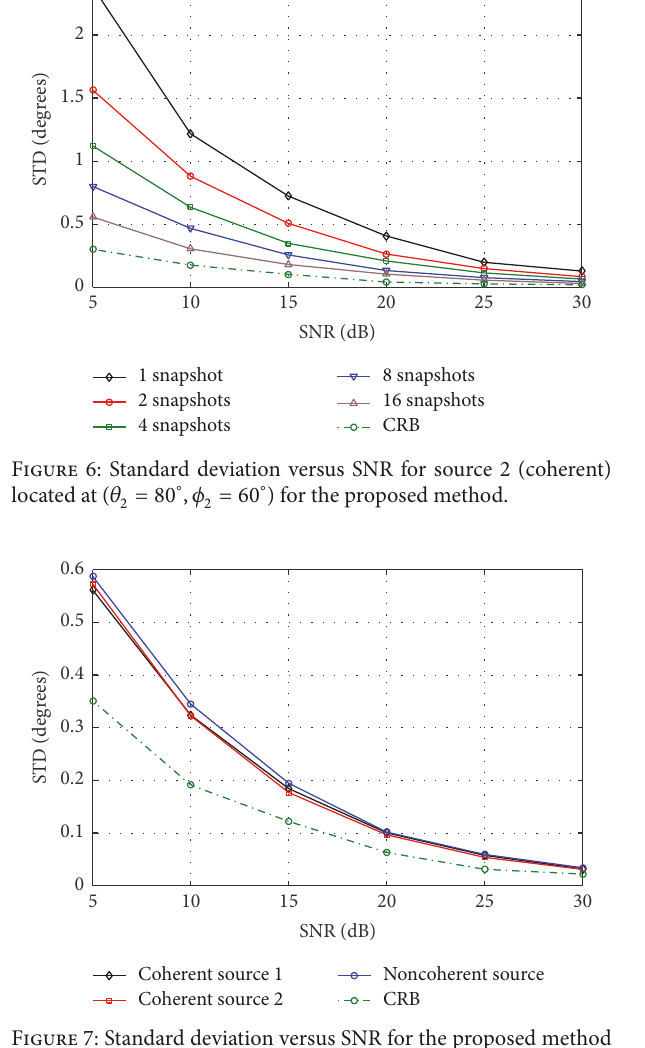
Figure 9: Scatter plot for three noncoherent sources located at (𝜃 1 = 50 ∘ ,𝜙 = 40 ∘ ) , (𝜃 = 60 ∘ , 𝜙 = 55 ∘ ) , and (𝜃 = 70 ∘ , 𝜙 = 65 ∘ ) with 1 2 2 3 3 SNR = 25